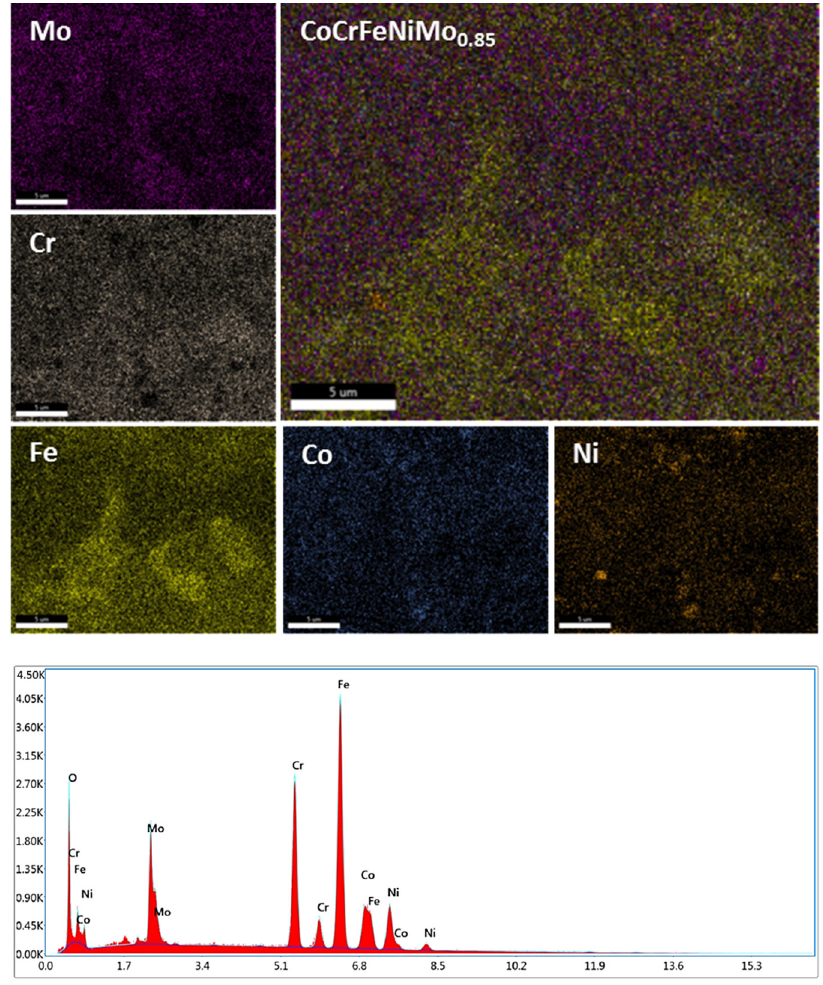
Figure 3. Mapping and EDS analyses results for the HEA coating.